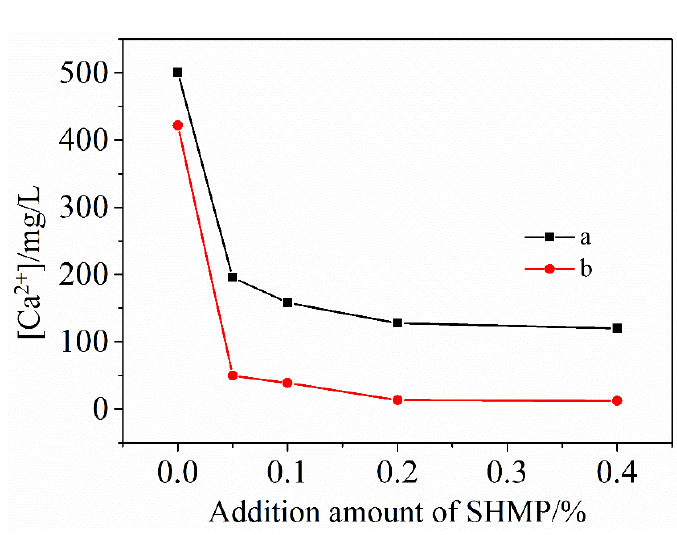
Figure 3. Effect of SHMP addition on Ca 2+ concentration in the filtrate after stirring for respectively: 5 Figure 3. E ff ect of SHMP addition on Ca 2 + concentration in the filtrate after stirring for respectively: min (a) and 30 min (b). 5 min (a) and 30 min